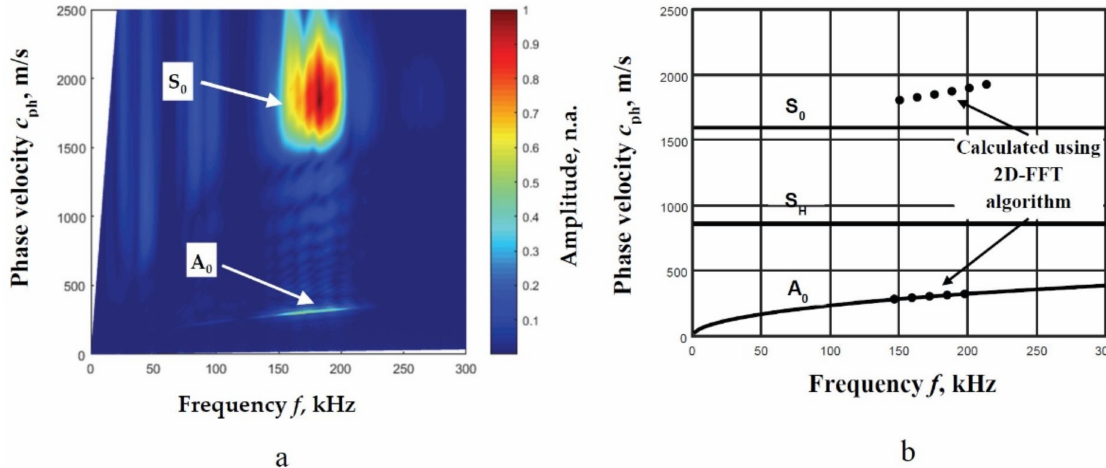
Figure 8. The 2D-FFT spectrum magnitude (colour) ( a ) and the reconstructed phase velocities of the A 0 and S 0 modes by estimation of the peak values of spectrum magnitude from 2D-FFT and SAFE calculations ( b